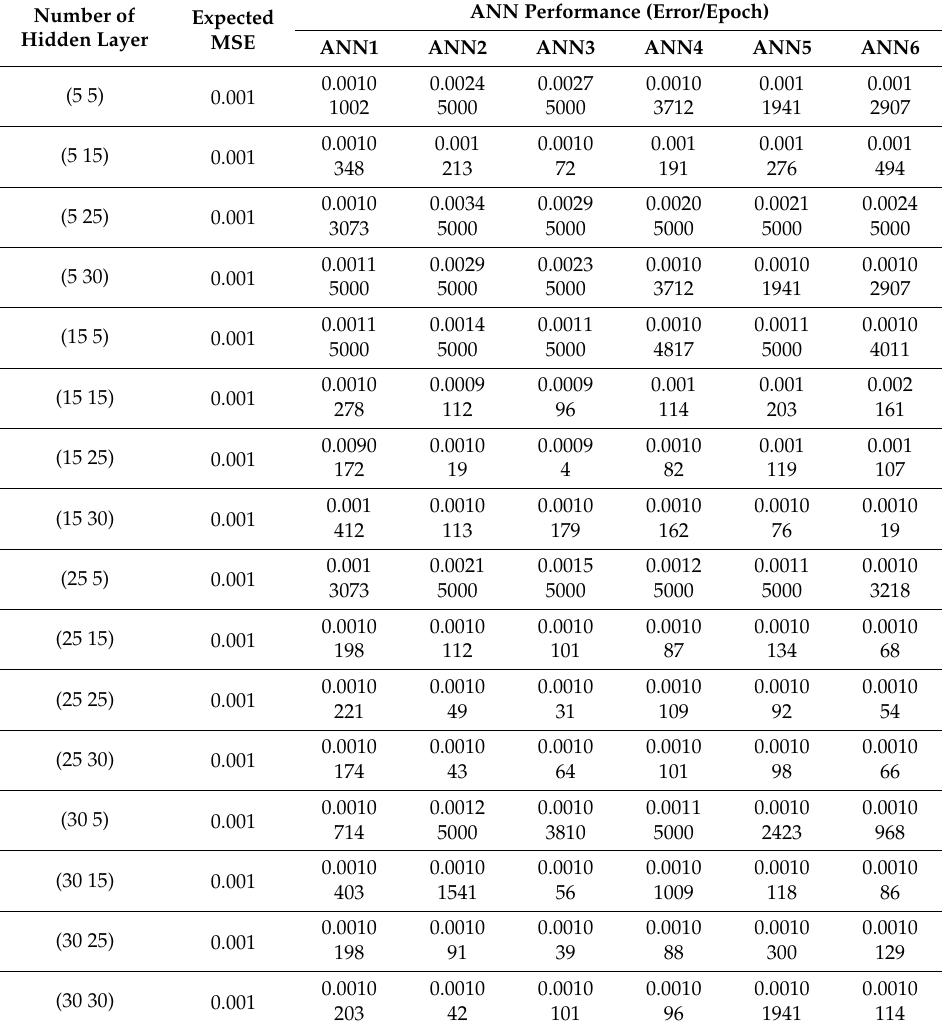
Table 5. Experiments for the number of process elements in hidden layers.